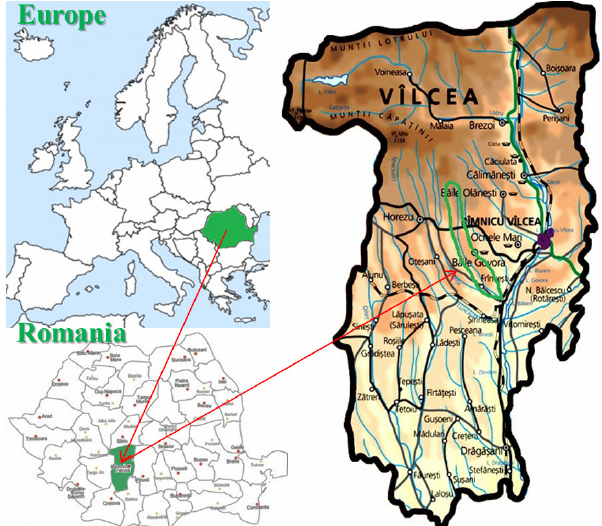
Fig. 1. Delimitation of the investigated